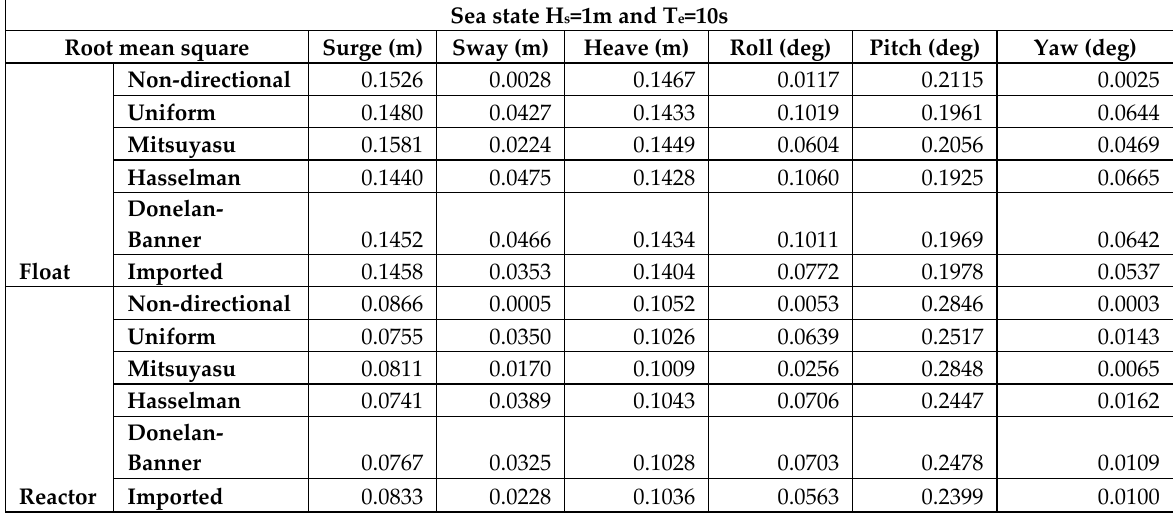
Table 5: Float and the reactor motion timeseries rms for the different optimization cases and for Hs=1m and Te=10s. Sea state H s =1m and T e =10s Root mean